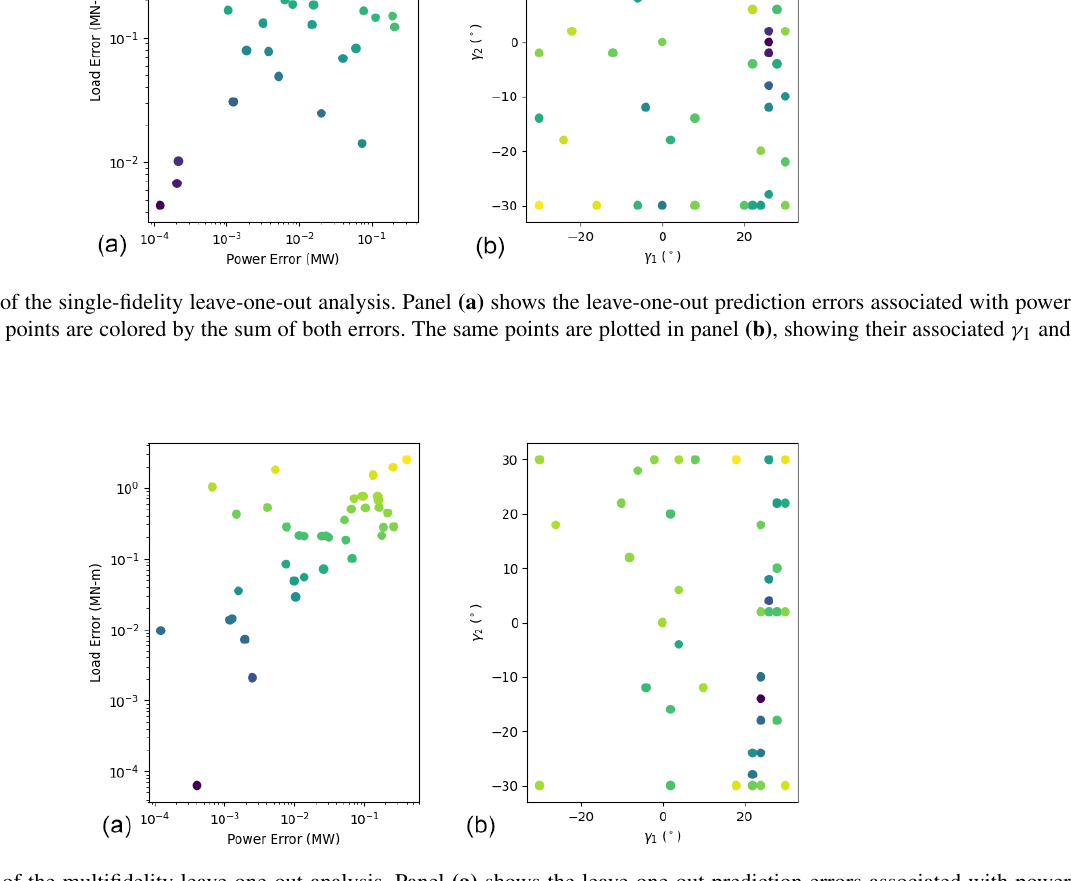
Figure A2. Results of the multifidelity leave-one-out analysis. Panel (a) shows the leave-one-out prediction errors associated with power and loading, and the points are colored by the sum of both errors. The same points are plotted in panel (b) , showing their associated γ 1 and γ 2